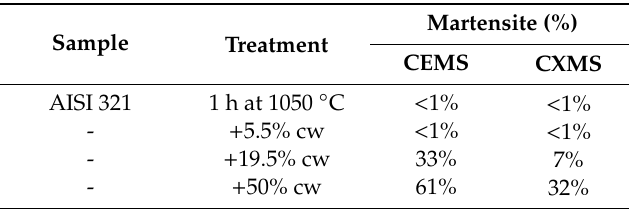
Figure 13. Conversion electron Mössbauer spectroscopy (CEMS) and CXMS profiles of AISI 321 steel after various degrees of cold working. Reproduced from [36], with permission from NDT International, 1977. Table 4. Percent of martensite in steel strips measured after heat treatment with subsequent various degrees of cold working (cw) as measured by conversion electron Mössbauer spectroscopy (CEMS) and conversion X-ray Mössbauer spectroscopy (CXMS). Reproduced from [36], with perimisision from NDT International, 1977.